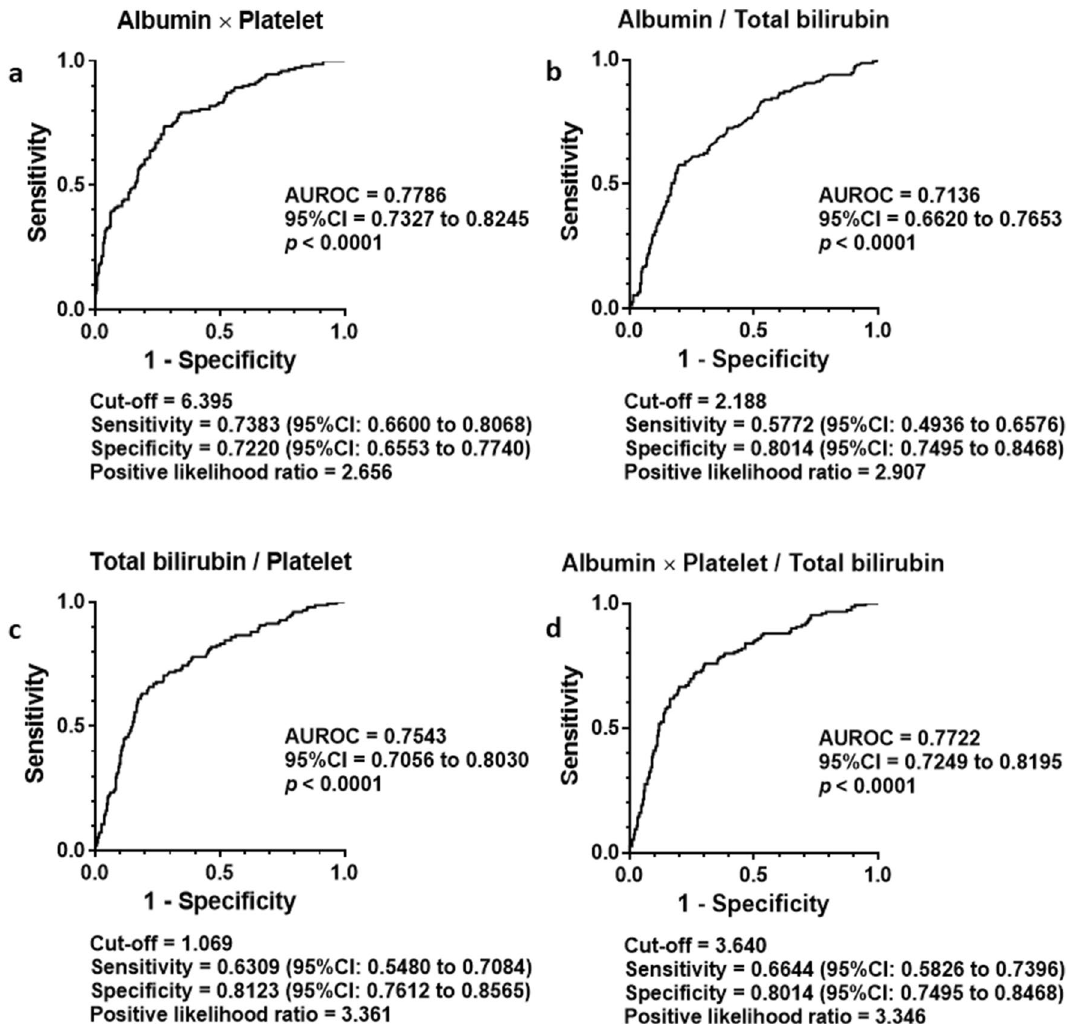
Figure 2. Differential diagnosis of advanced liver fibrosis by newly generated fibrosis indexes in the training cohort. ROC analysis to assess the ability of fibrosis indexes to differentiate advanced liver fibrosis (F3–4) from nonadvanced fibrosis (F1–2) yielded AUROC 0.7786 in Albumin platelet product ( a ), 0.7136 in Albumin bilirubin quotient ( b ), 0.7543 in Bilirubin platelet quotient ( c ) and 0.7722 in Three math; Albumin × platelet/ (total bilirubin × 100) ( d ). A cut-off value of Albumin platelet product = 0.6395 presented 0.7383 of sensitivity and 0.7220 of specificity with 2.65 of positive likelihood ratio to differentiate advanced fibrosis from non advanced fibrosis ( a ). P values less than 0.05 were considered statistically